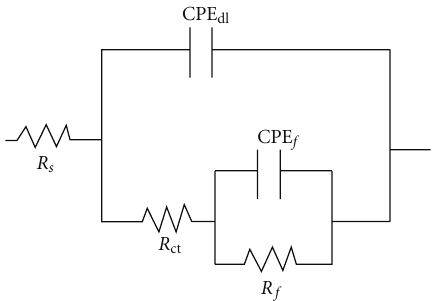
Figure 12: Electric circuit used to simulate the EIS